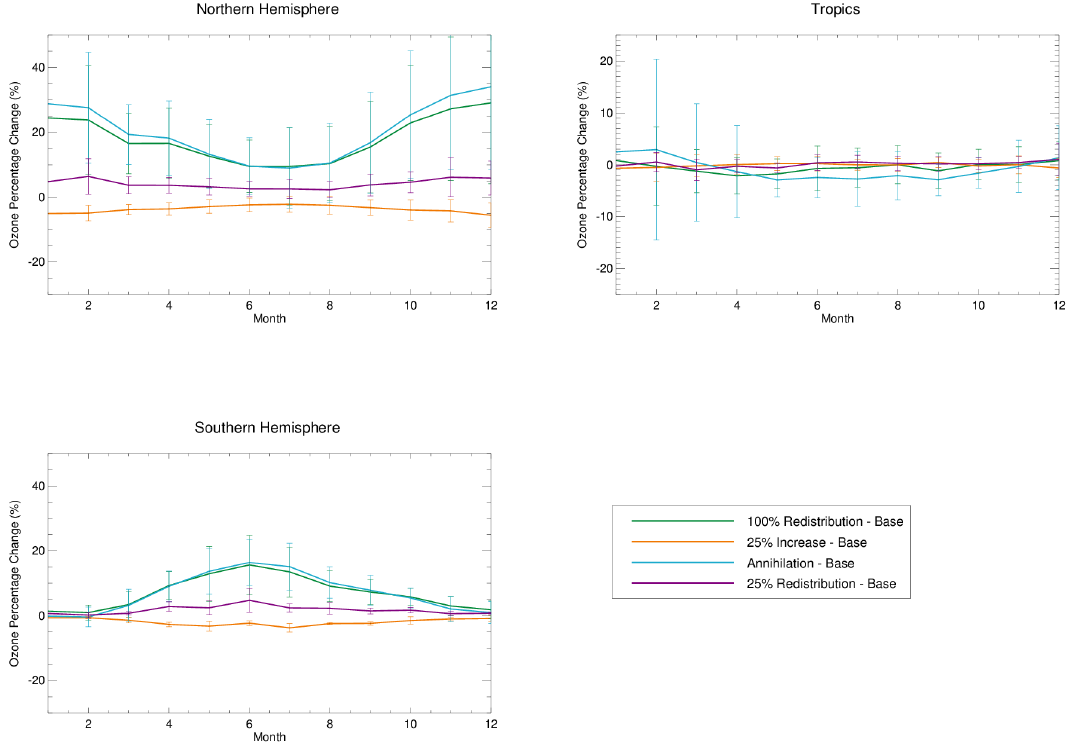
Fig. 4. Percentage change in megacity surface ozone for emission perturbation scenarios. Megacities are grouped and averaged according to latitudinal bands; Northern Hemisphere megacities are considered those that are located > 25 ◦ N, and Southern Hemisphere megacities > 25 ◦ S. Lines are coloured according to scenario (see key bottom right). Error bars indicate one standard deviation from the mean.